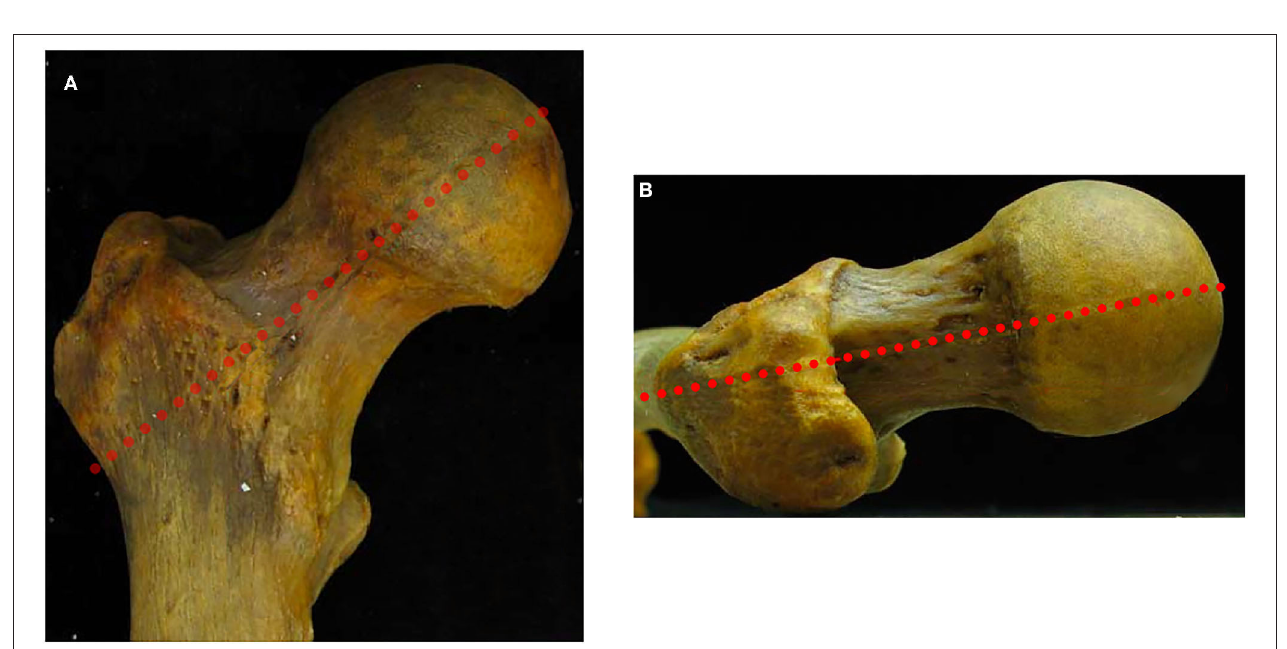
FIGURE 2 | Coronal ( A ) and axial views ( B ) of a cadaveric femur demonstrating the manner in which the femoral neck was divided into superior/inferior and anterior/posterior halves.